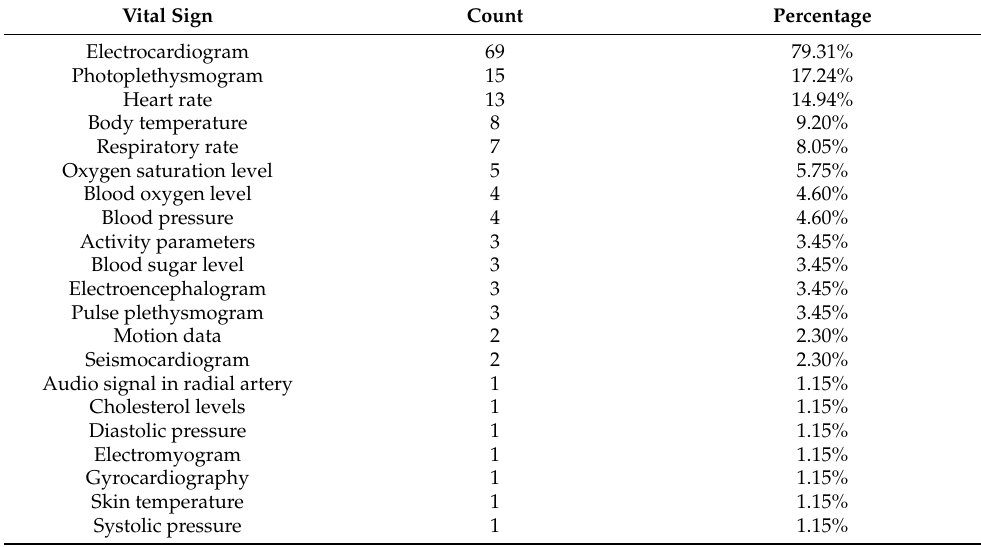
Table 3. Vital signs used in studies with count and percentages.